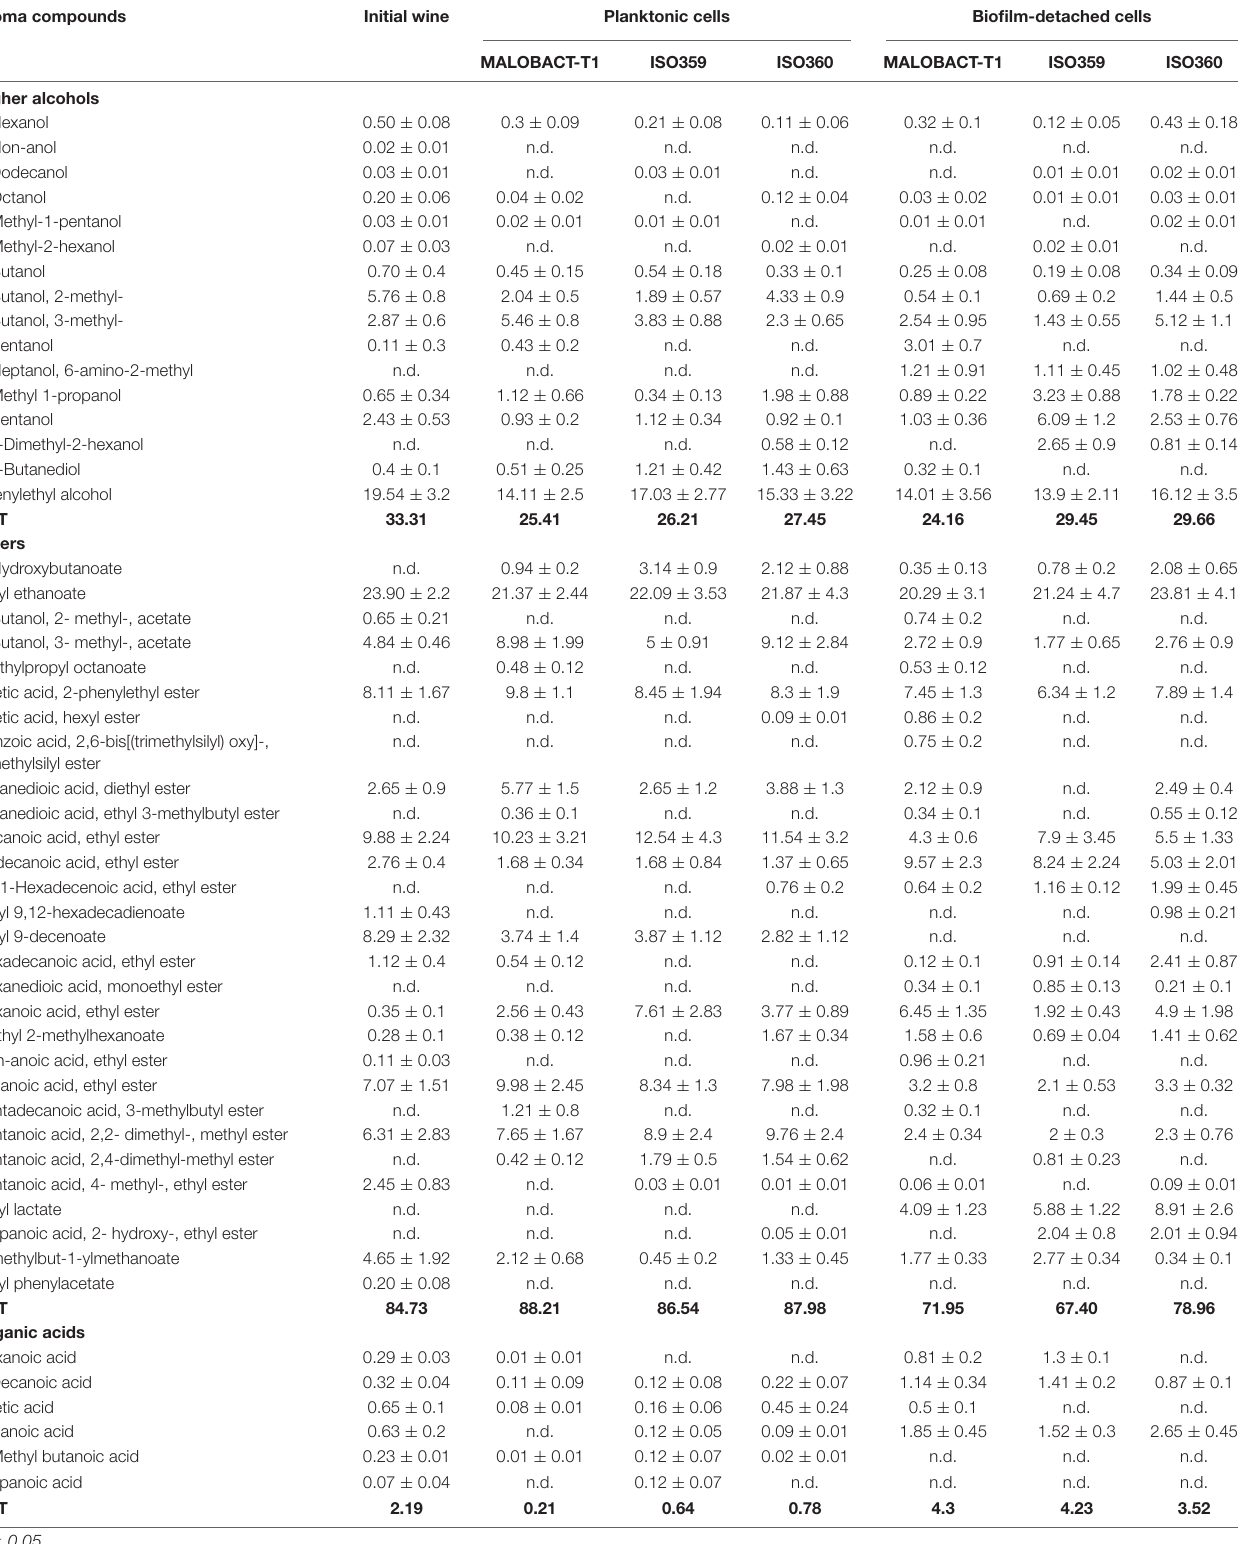
TABLE 1 | Main aroma compounds produced by planktonic and biofilm detached cells. Aroma